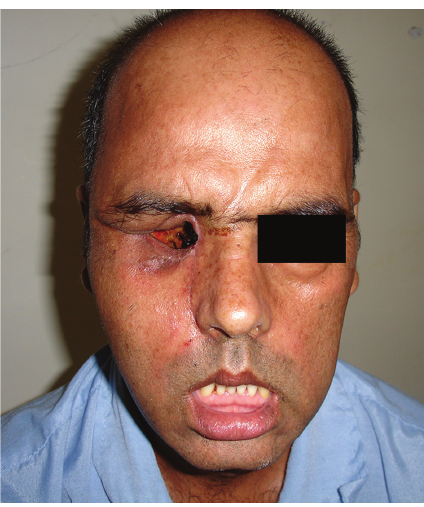
Figure 1: A 43 year-old man a ff ected by zygomycosis and bilateral facial nerve paralysis.